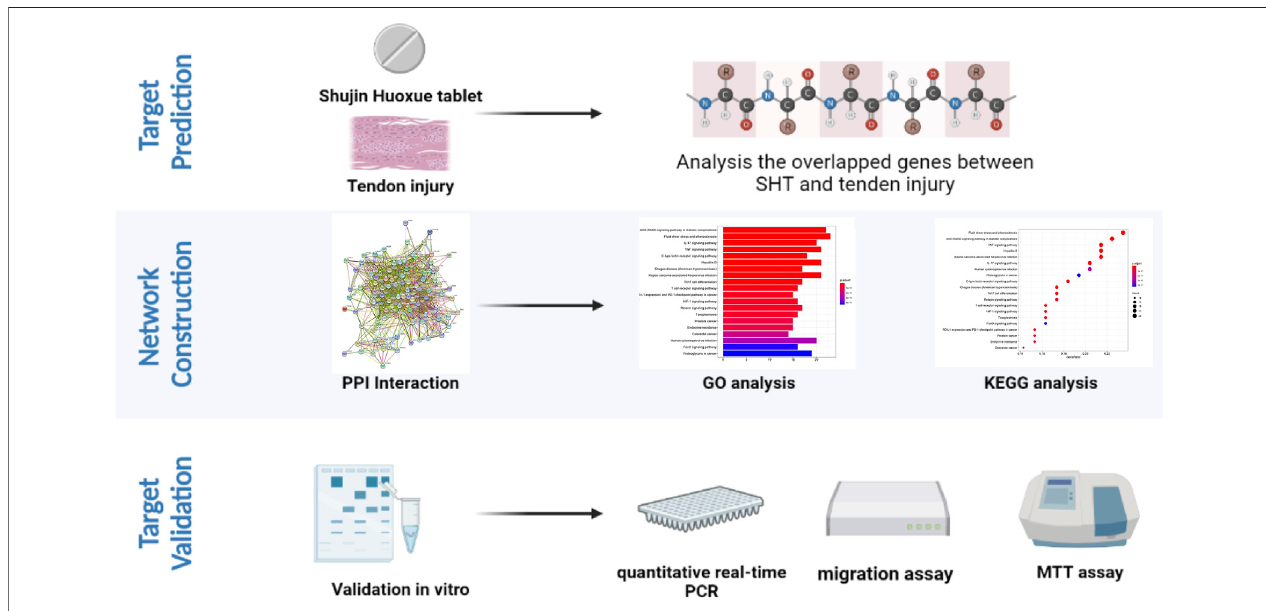
FIGURE 1 | Flow chart of the research strategy created with